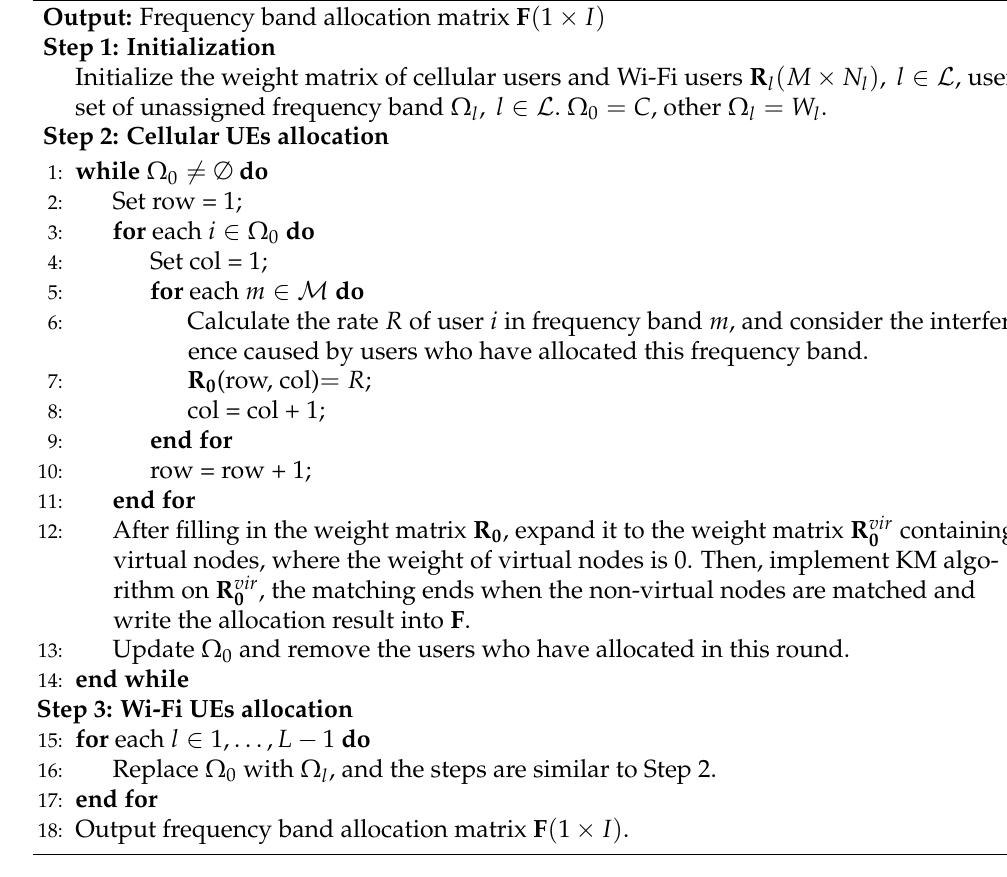
Algorithm 1 Frequency resource allocation algorithm